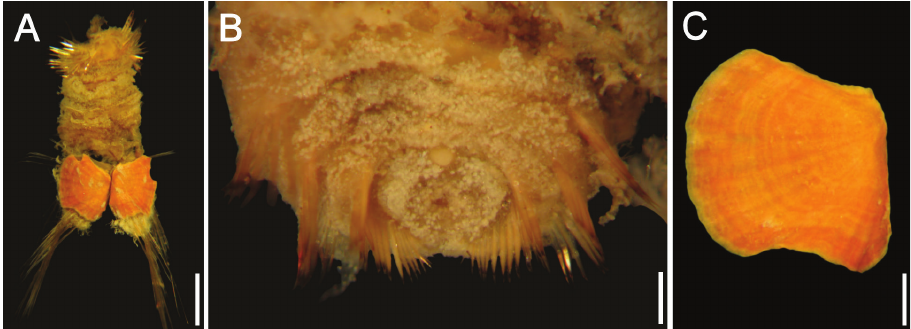
Figure 5. Sternaspis maureri sp. n., A Holotype (LACM 5679), ventral view, shield variably broken B Paratype (LACM 5680), anterior end, seen from above C Ventro-caudal shield, detached right part. Bars A 1.9 mm B 0.4 mm C 0.5